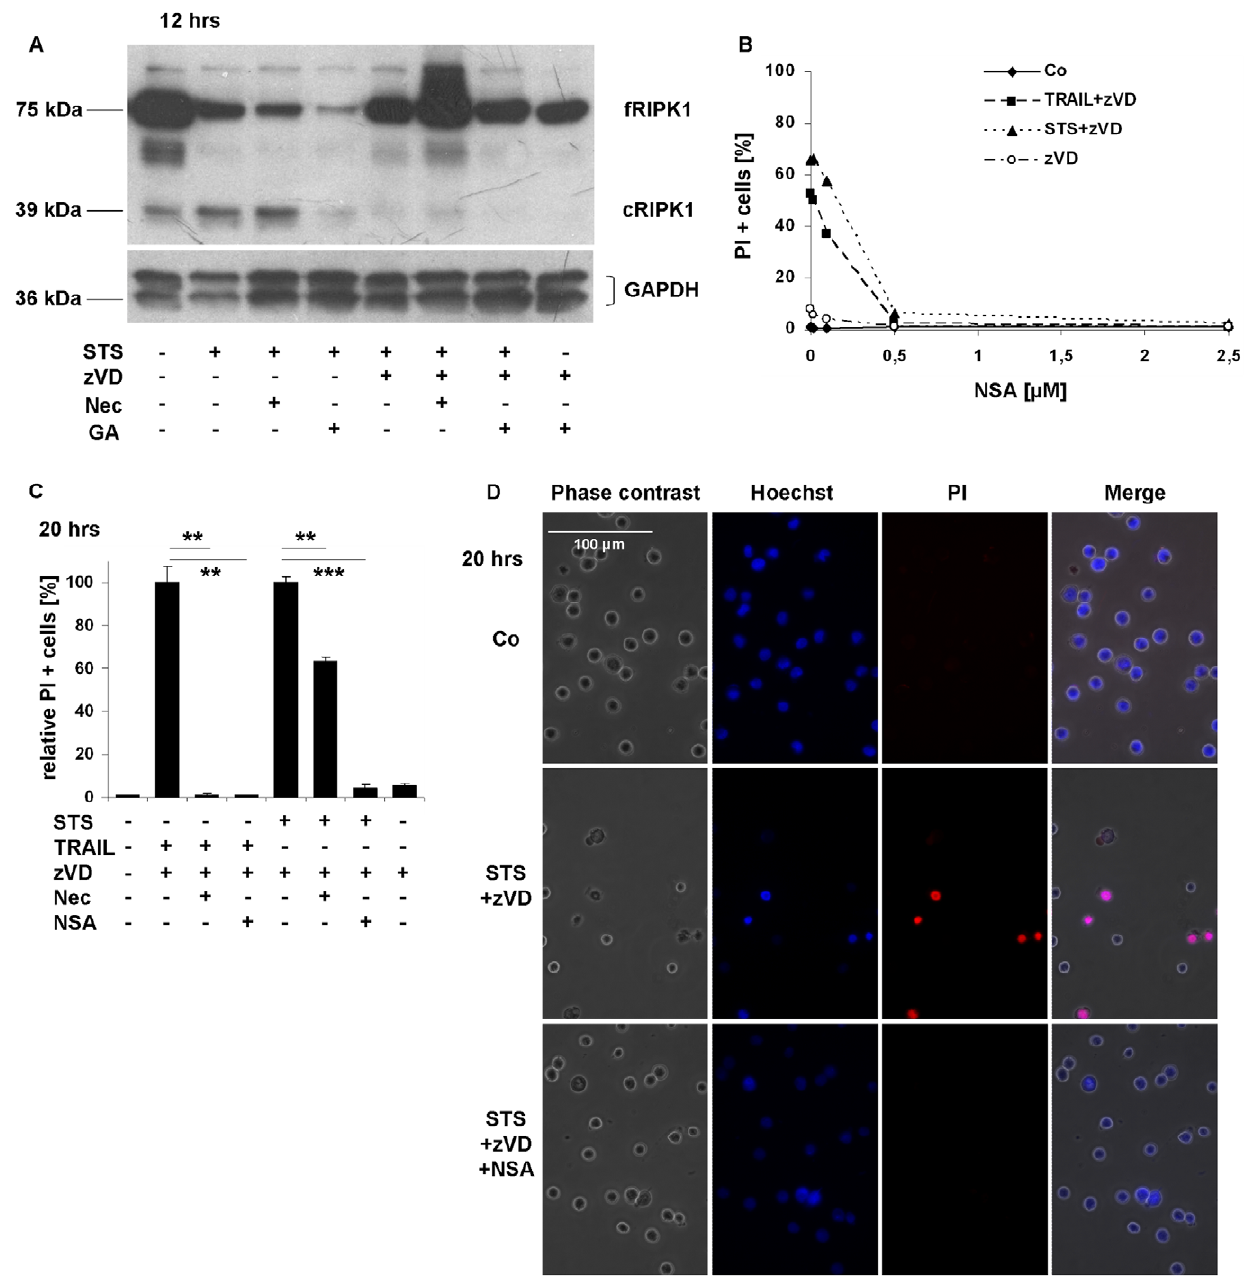
Figure 3. STS induces RIPK1 and MLKL-dependent necroptosis. (A) zVD hampered RIPK1 fragmentation triggered by STS for 12 hrs. Western blot analysis was performed for the detection of RIPK1 protein level and presence of cleaved fragment due to caspase activity (representative of n=2). (B) NSA reduced TRAIL and STS-induced necroptosis in a concentration-dependent manner after 20 hrs incubation time – representative experiment. U937 ells were exposed to STS (1 m M) and TRAIL (50 ng/mL) and varying concentrations of NSA (0–2.5 m M) in the presence of zVD (5 m M) for 20 hrs. Percentage of PI positive cells was determined. (C-D) NSA (0.5 m M) significantly hampered both the TRAIL and STS-triggered necroptosis. (C) Relative percentage of PI positive cells was determined by FACS analysis (n=3). Values are mean 6 SD. *, P , 0.05, **, P , 0.01 and ***, P , 0.001 calculated by Student’s t-probe. (D) Morphological signs of apoptosis and necrosis are shown in representative fluorescent microscopic images (400x) of Hoechst/PI double stained U937 cells (n=2). Scale bar on the first subfigure applies to all the figures in the